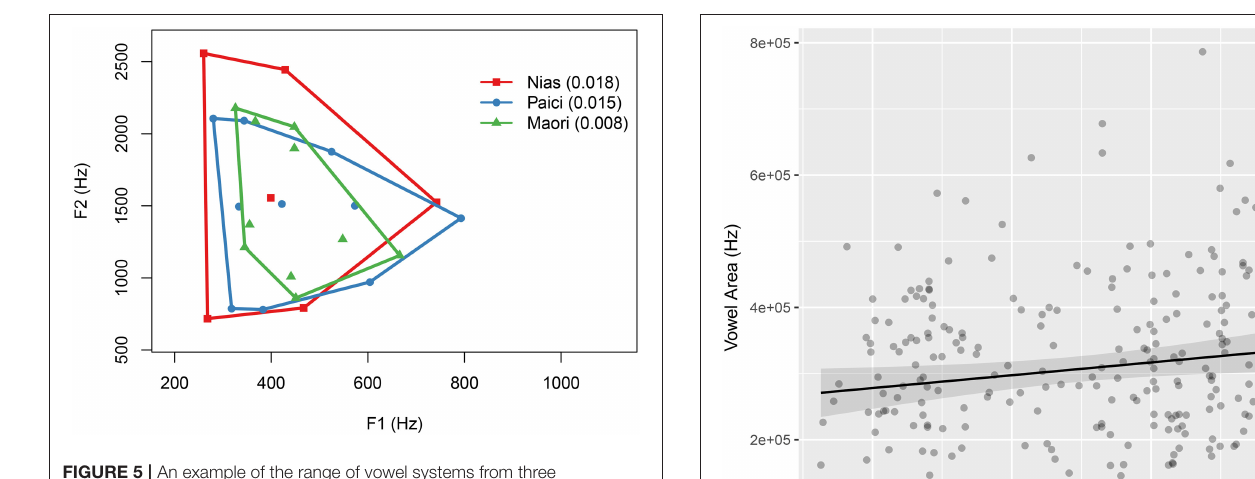
FIGURE 5 | An example of the range of vowel systems from three Austronesian languages. The humidity in which the languages are spoken are shown in parentheses next to the language name in the legend.